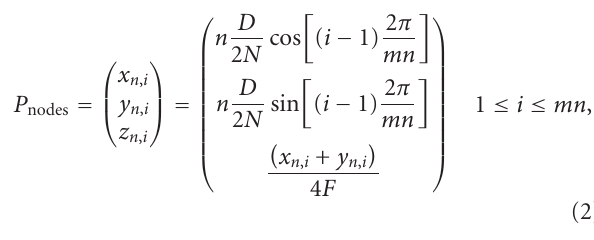
Figure 1: Flat-facet concentrator: (a) a layout of nodes with m = 6 and t = 294 facets, placed in N = 7 rows and (b) the mapping procedure for generating the triangular facets membrane